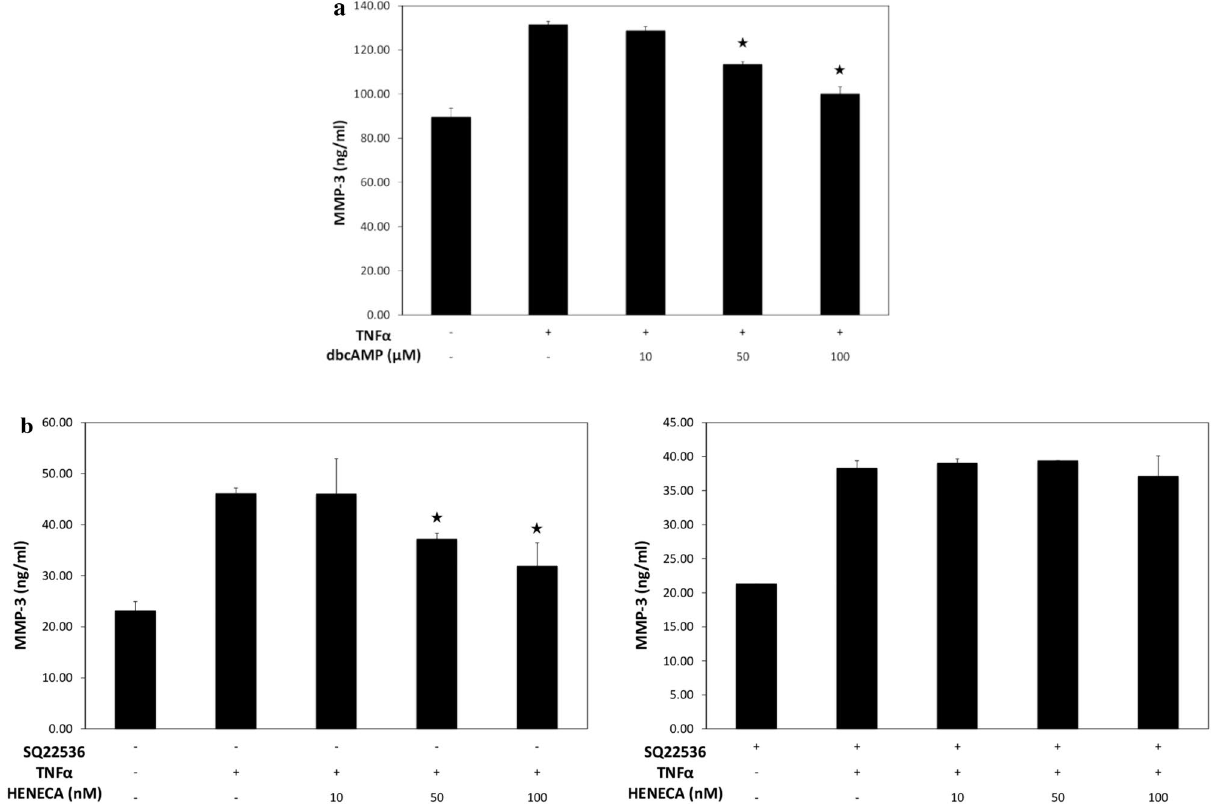
Figure 5. Effect of cAMP analog dbcAMP and the adenylate cyclase inhibitor SQ22536 on TNFα-induced enhancement of MMP-3 production. Activation of cAMP signaling suppressed TNFα-induced MMP-3 production ( a ). MH7A cells were incubated for 24 h in TNFα (25 pg/ml) with or without the indicated concentration of dbcAMP, and MMP-3 concentration measured in the culture medium. In some experiments, the cells were also pretreated for 30 min with 0.1 mM of the adenylate cyclase inhibitor SQ22536 ( b ). MMP-3 was then measured in the culture medium. The suppressive effect of HENECA on TNFα-induced MMP-3 production was blocked by SQ22536 pretreatment. Experiments were repeated three times and data are presented as mean ± SD. ★ p < 0.01 vs. TNFα